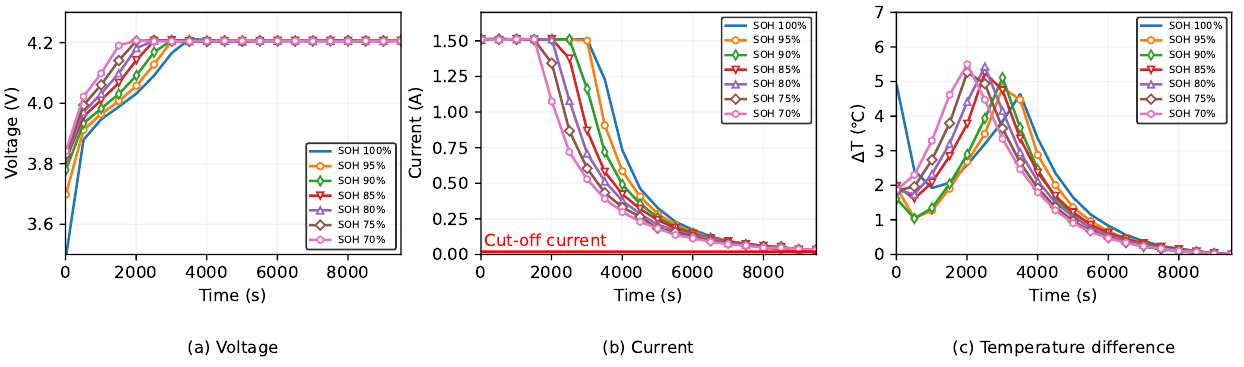
Figure 2. Data sampled by constant time intervals during charging of battery